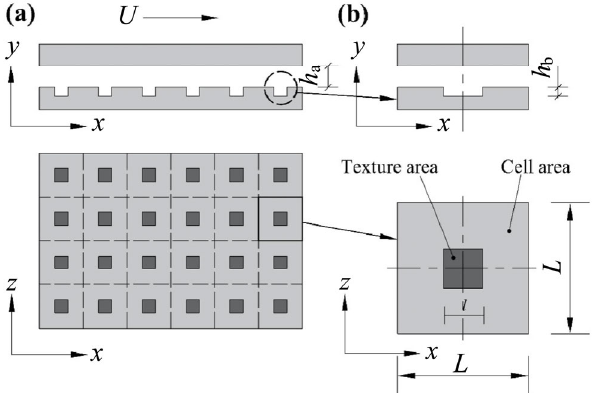
Fig. 1 Texture design of (a) textured parallel slider and (b) square textured unit